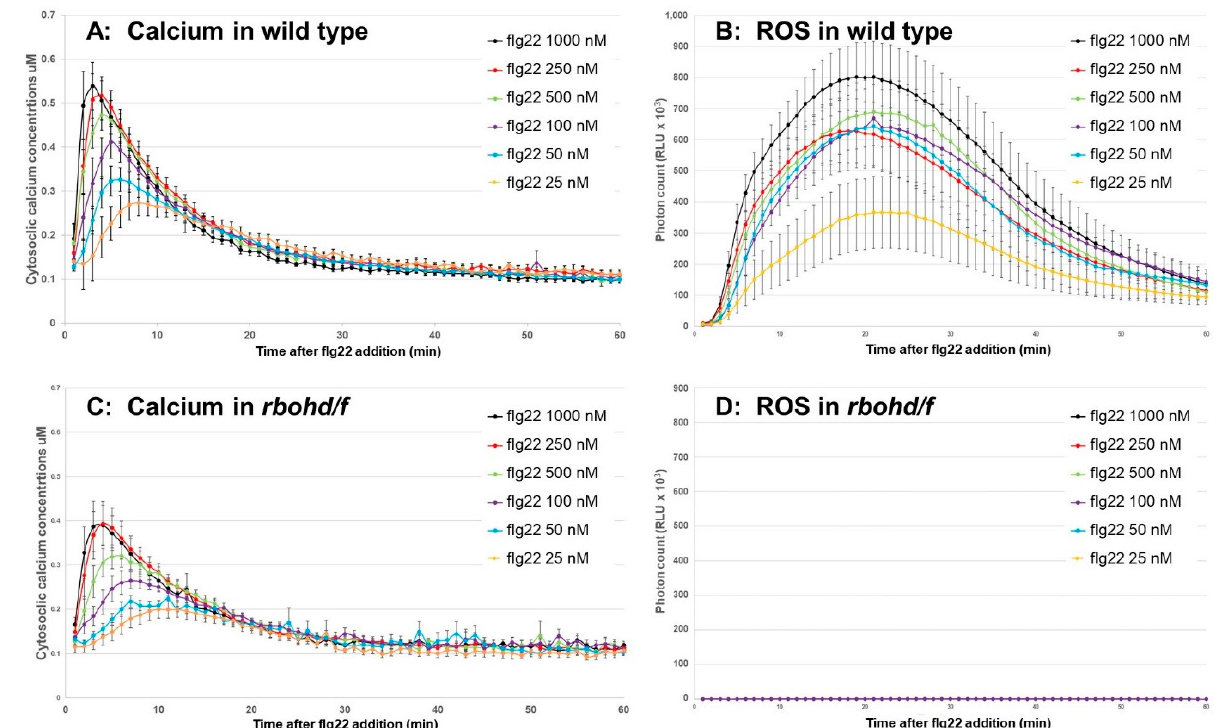
Figure 4. The effect of apoplastic ROS generated by RBOHs on calcium signaling. A flg22-dose-dependent response in cytosolic calcium elevation ( A , C ) and apoplastic ROS production ( B , D ) was compared between the wild-type plant ( A , B ) and the double knockout mutant rbohd/f , both of which are expressing apoaequorin. Measurements of calcium and ROS were performed over 60 min following addition of flg22 at a final concentration of 25, 50, 100, 250, 500, or 1000 µM.